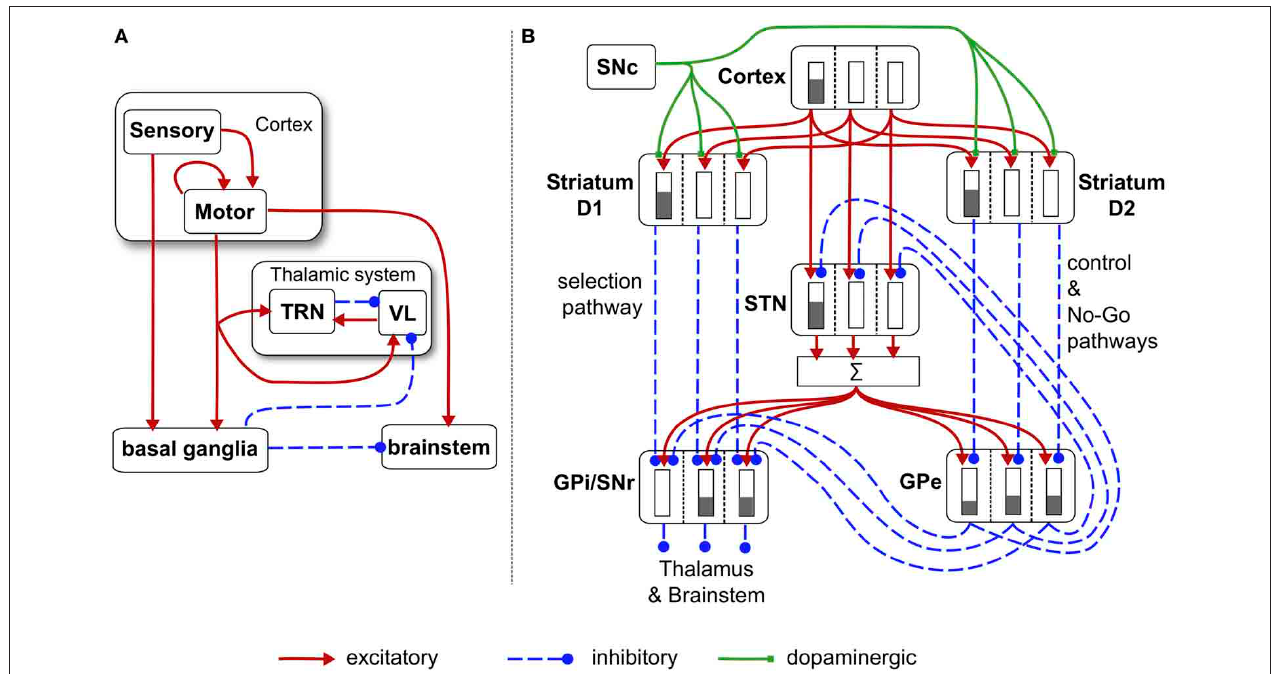
(GPi) and substantia nigra pars reticulata (SNr); globus pallidus external segment (GPe), and substantia nigra pars compacta (SNc). The three action channels are shown in this panel, and a typical set of activities indicated in cartoon form by the gray bars (the channel on the left is highly salient causing suppression of basal ganglia output on that channel). The summation box below STN is not anatomically present—it is graphic device to indicate that each target of STN sums its inputs across channels from